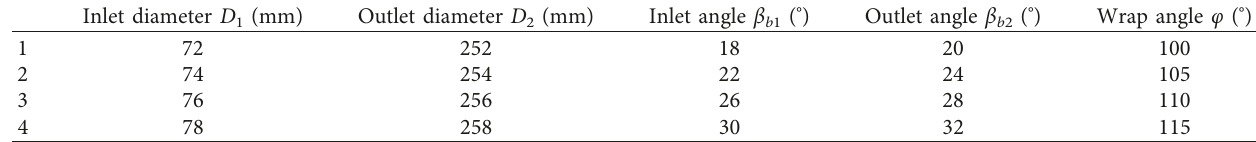
Table 2: Orthogonal experimental factors of lining pump impeller level.